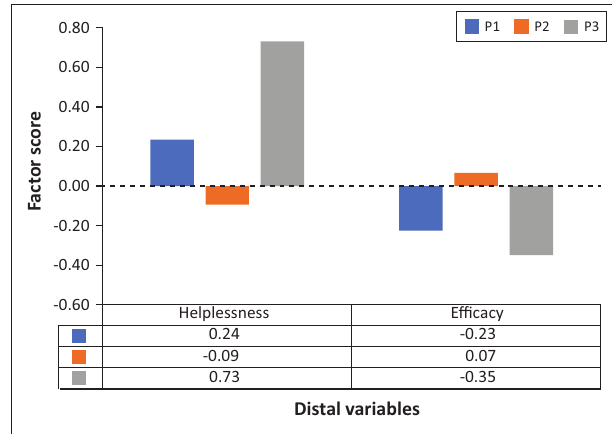
FIGURE 3: Perceived distress and positive stress factor scores of different